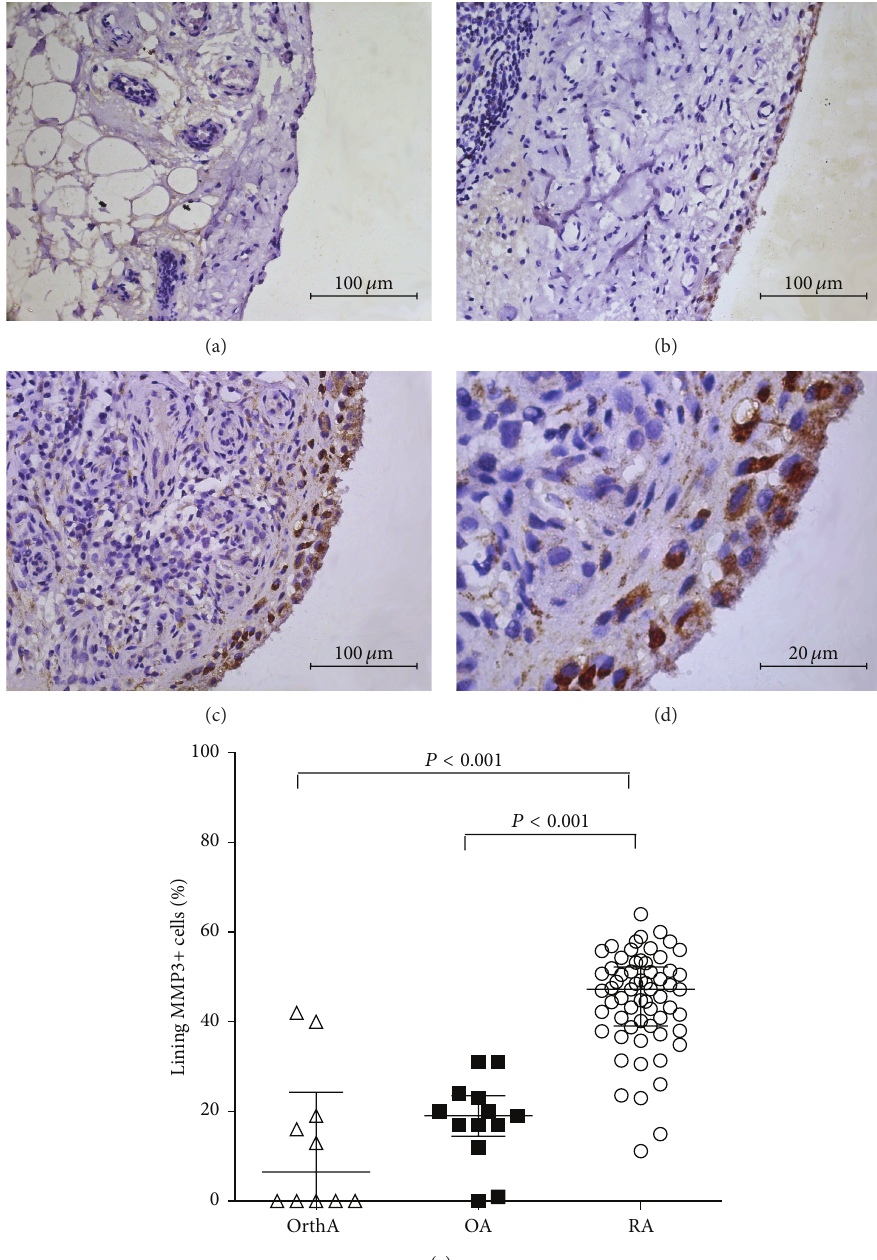
Figure 1: Representative immunohistochemical findings of synovial MMP-3 expression. (a) Mild synovial MMP-3 expression in lining cells in a discoid meniscus patient. (b) Moderate synovial MMP-3 expression in lining cells in an OA patient. (c) and (d) Intensive synovial MMP- 3 expression in lining cells in a RA patient. (a, b, c) original magnification × 400; (d) original magnification × 1000. (e) Percentage of lining MMP3+ cells in OrthA, OA, and RA